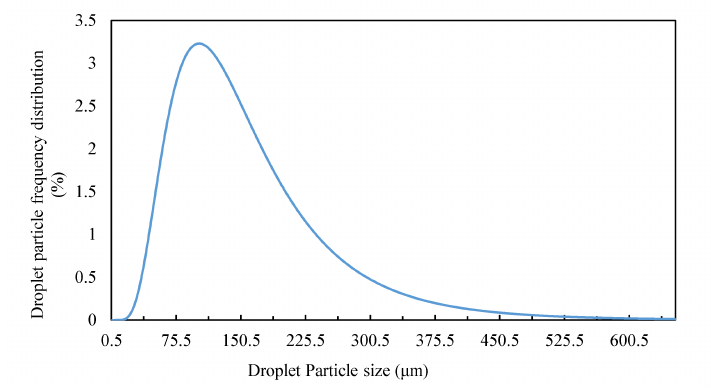
Figure 7. Droplet particle size normal distribution.